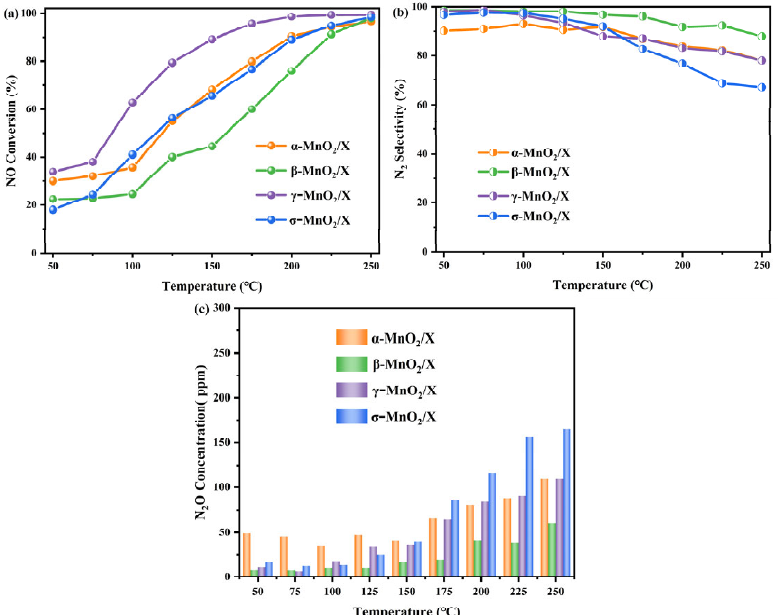
Figure 2. NH 3 -SCR activity of α -MnO 2 /X, β -MnO 2 /X, γ -MnO 2 /X, and σ -MnO 2 /X catalysts at different temperature: ( a ) NO conversion of all the catalysts at different temperature; ( b ) N 2 selectivity of all the catalysts at different temperature; ( c ) N 2 O concentration of all the catalysts at different temperature. Reaction conditions: 500 ppm of NO, 500 ppm of NH 3 , 11% O 2 , N 2 as balance, and GHSV of 36,000 h − 1 .